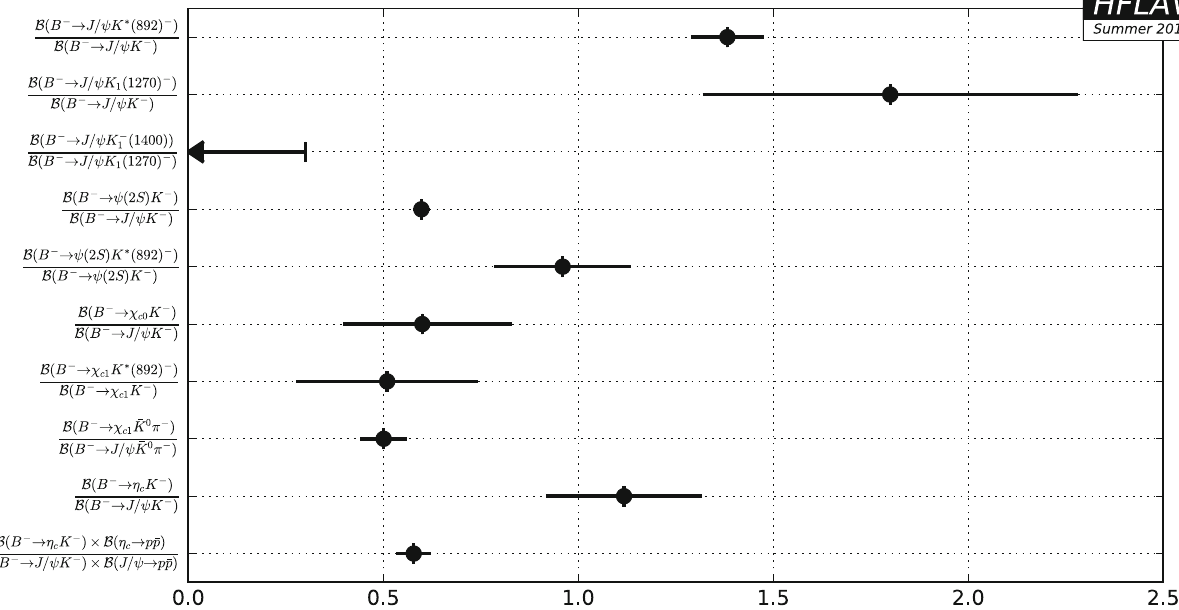
Fig. 137 Summary of the averages from Table 168